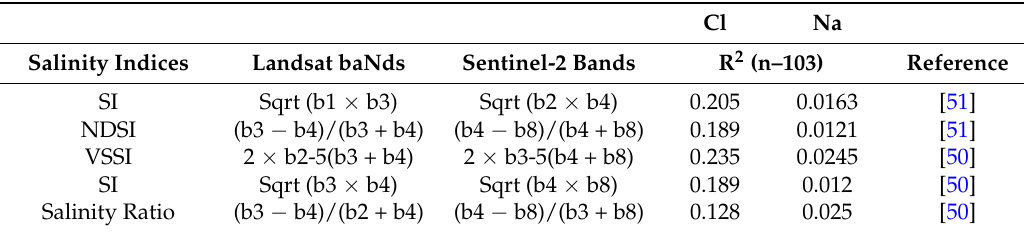
Table 5. Coefficient of determination between different salinity indices (resampled to Sentinel-2 configuration) and the Cl and Na contents of the plant samples.